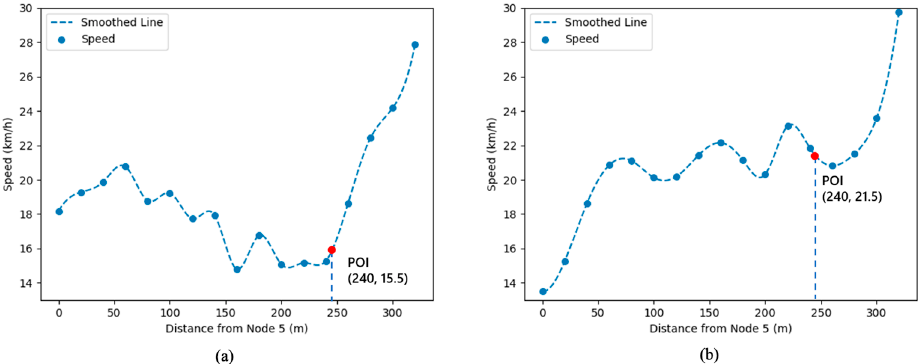
Figure 4. Relationship chart of POI link location and traffic speed: ( a ) 15:15~15:30; ( b ) 15:30~15:45.